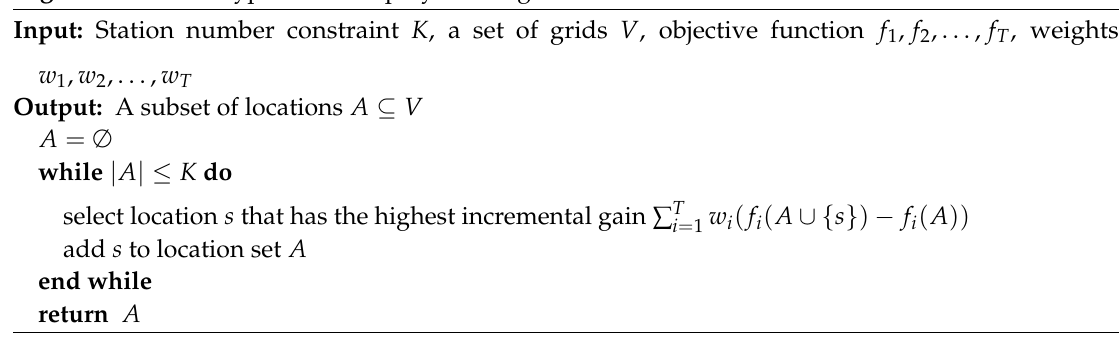
Algorithm 1 Multi-type sensor deployment algorithm for one-with-all